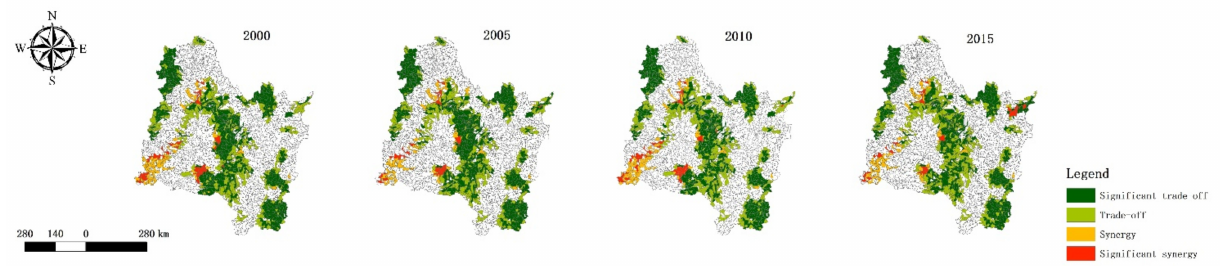
Figure 18. The synergy/trade-off relationship between crop production and biodiversity. The synergy/trade-off relationship between crop production and carbon sequestra- tion in the spatial charactaristic from 2000 to 2015 is shown in Figure 19 and Table S1. In 2000, crop production and carbon sequestration showed a very significant trade-off relationship in the core area of Changbai Mountain, which is dominated by broadleaf forests and coniferous forests. The characteristic of the trade-off is that the crop production is low, and the amount of carbon sequestration reaches a higher level. The meadows and arable land in the marginal area of Changbai Mountain have increased, and the crop production has increased significantly. The amount of carbon sequestration in the arable land has also remained within a relatively high range. Therefore, the marginal area of Changbai Mountain shows a synergistic relationship between crop production and carbon sequestration. There are some significant trade-off areas in the core area of the Songnen Plain, but there are some synergistic areas on the western side of the Songnen Plain, and the crop production and the amount of carbon sequestration both show low levels. In 2005, the significant trade-off area of Changbai Mountain was reduced to the southern part of Changbai Mountain, and the synergy/trade-off area of the Songnen Plain was also reduced. In the northwestern part of the Great Khingan Mountains, a synergistic area appears. This area is dominated by coniferous forests, broadleaf forests, and swamps, and the soil type is luvisols. The synergistic feature is reflected within the low range of crop production and carbon sequestration in this area. In 2010, the two core areas of the Songnen Plain and the southern foot of Changbai Mountain were still retained, and the synergistic area in the northwest of the Great Khingan Mountains disappeared. From 2000 to 2010, the southern foot of Changbai Mountain was very stable as a significant trade-off area, and some EUs at the edge showed a synergistic relationship between crop production and carbon sequestration. Meanwhile, the synergy/trade-off area between the western part of the Songnen Plain and the southern part of the Great Khingan Mountains is also relatively stable. In 2015, the Songnen Plain’s synergy/trade-off area was greatly reduced, and